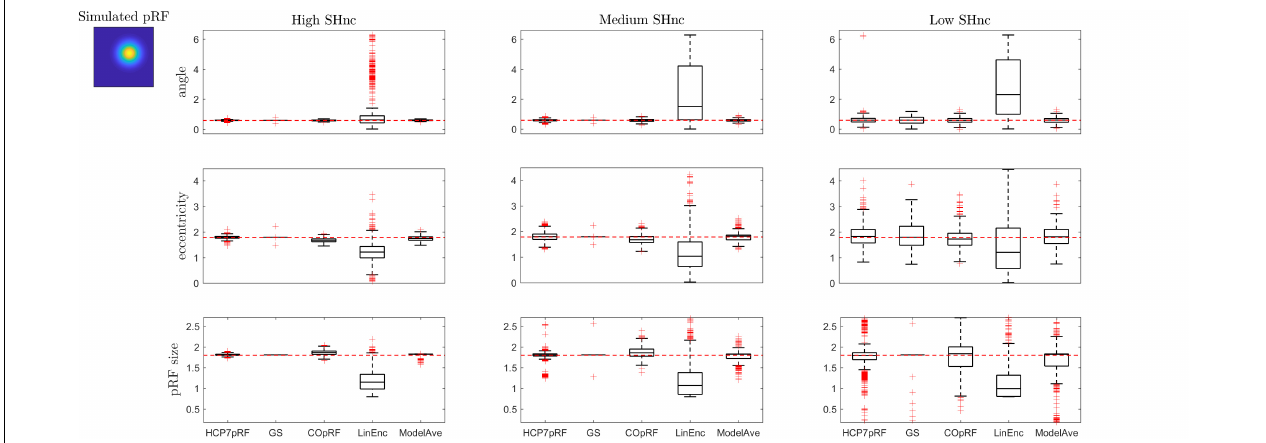
FIGURE 7 | Boxplots ([25, 50, 75] percentiles over 1000 simulated datasets) represents the estimated pRF parameters using different estimation procedures for a broad two-dimensional pRF (presented in extreme left). Each column refers to a different split-half noise ceiling level from high to low: High SHnc = 0.63, Medium SHnc = 0.35, Low SHnc = 0.1. Each row presents the results for each of the pRF parameters: angle, eccentricity and pRF size. Outliers (in the estimated pRF parameters) are denoted by red + symbols and defined by the condition of being outside the 1.5 interquartile range. The horizontal red line indicates the pRF parameters used to simulate the data. TABLE 1 | Statistical analysis of the bias of the estimates of the angle, eccentricity and pRF size obtained when simulating a narrow visual pRF (angle = 0.59 radians, eccentricity = 1.79 ◦ , pRF size σ = 0.23 ◦ ) at different noise levels. Low Noise Medium Noise High Noise Angle Ecc. Size Angle Ecc. Ecc.